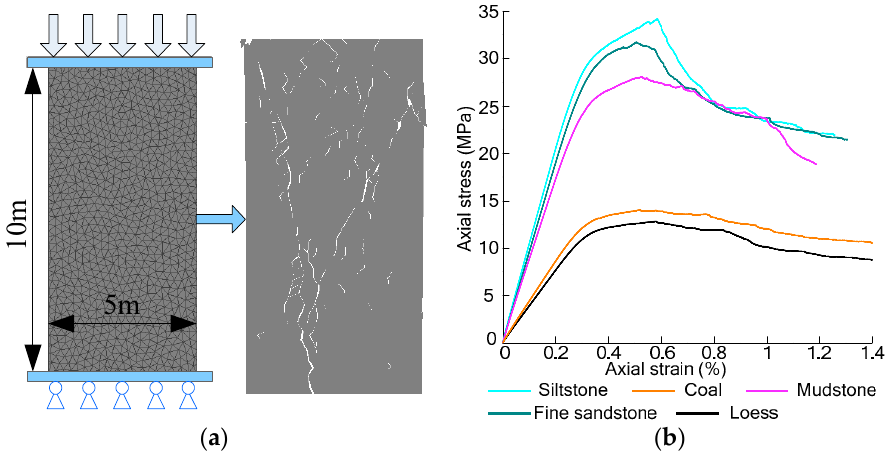
Figure 5. Simulated unconfined compression tests and obtained optimal axial stress–axial strain curves: ( a ) Unconfined compression tests; ( b ) stress–axial strain curves. Table 2. Physical and mechanical parameters of rock mass used in the UDEC model.